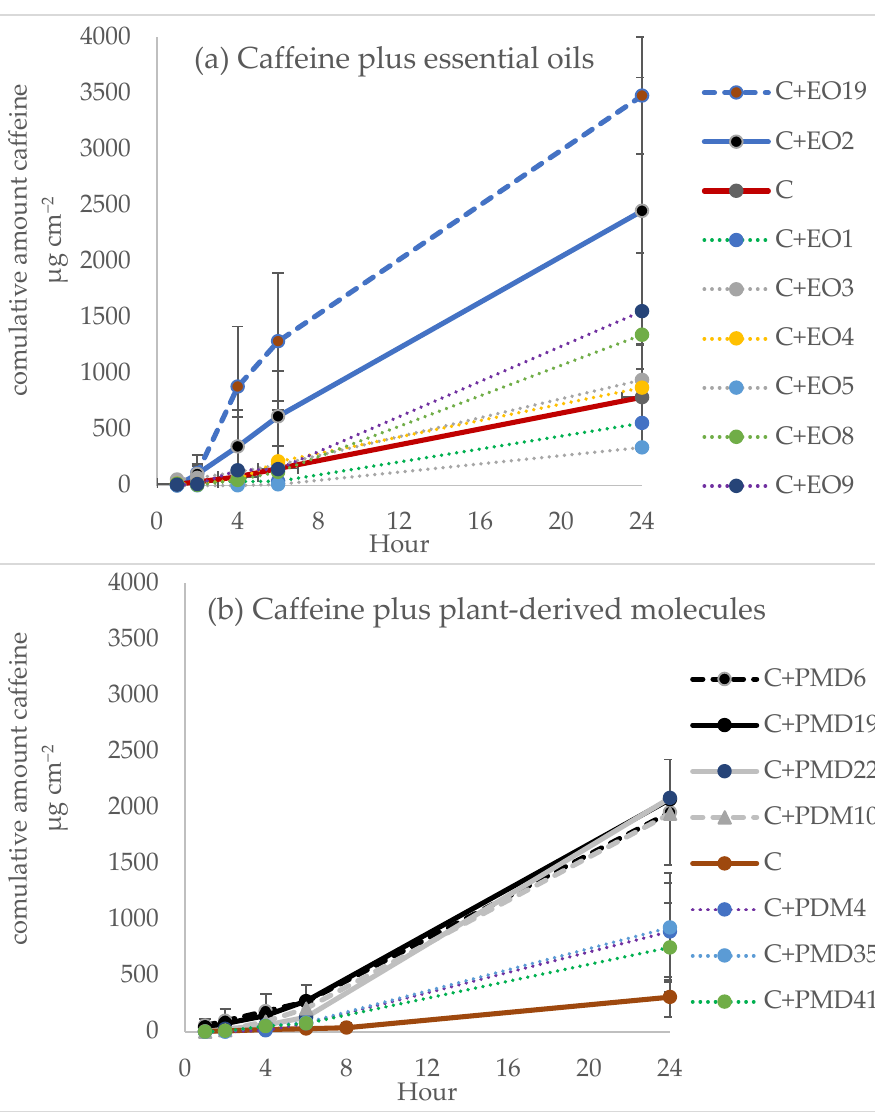
Table 3. Among the EOs, EO19 ( Lippia origanoides , Thymol chemotype) and EO2 ( Turnera diffusa ) significantly enhanced the J ss values and permeability coefficients (Kp) with an enhancement index (EI) of 3.7 and 3.0, respectively. In contrast, the lowest enhancement in caffeine flux was obtained with EO1 ( Steiractinia aspera ), EO4 ( Calycolpus moritzianus ), and EO5 ( Piper anduncum ) with EI values lower than 0.9. Lippia origanoides H.B.K. (Verbe- naceae) is an aromatic plant growing in different Colombian regions and used in traditional medicine due to its antioxidant, anti-viral, anti-genotoxic, anti-parasitic, and repellent activ- ities [19,20]. As revealed by chemical analysis, two of their different chemotypes [21] were tested in this work. The phellandrene chemotypes EO3 and EO9 were the least caffeine PE compounds, with EI values of 1.15 and 1.41, respectively, and the carvacrol (EO8) and thy- mol (EO19) chemotypes were the best, with EI values of 1.6 and 3.7, respectively. The higher enhancement in caffeine permeation induced by EO19 could be due to its monoterpene constituents ranking from thymol > p -cymene > carvacrol > β -myrcene and γ -terpinene (Table 1).